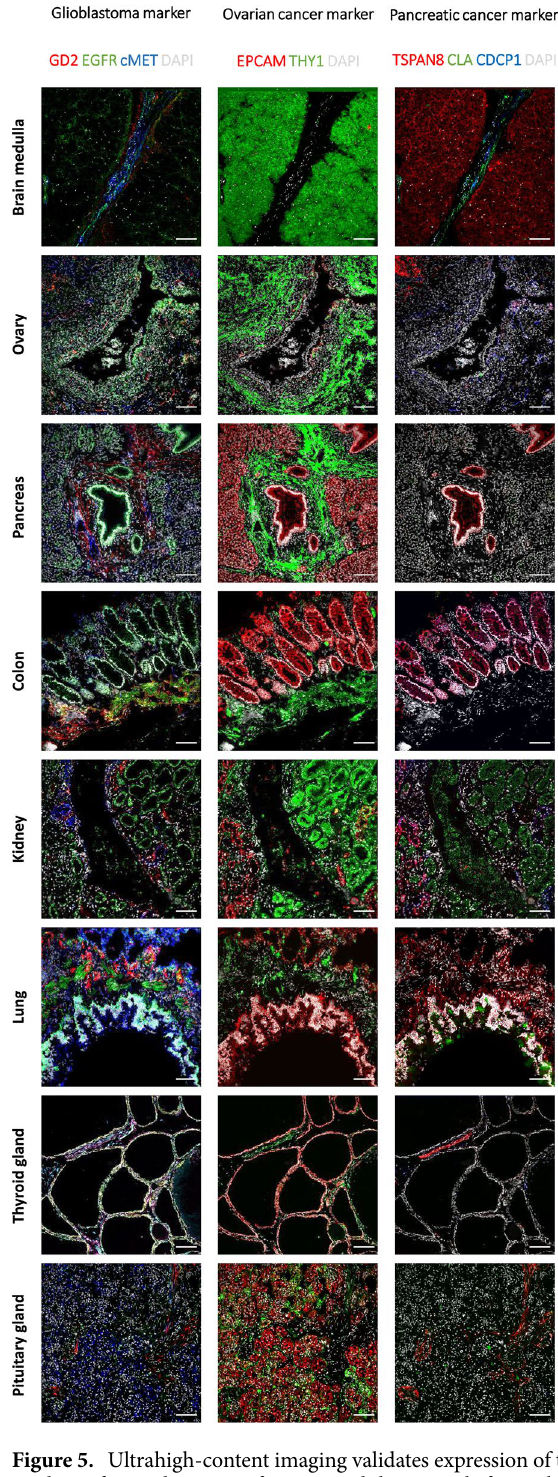
Figure 5. Ultrahigh-content imaging validates expression of target candidates on healthy human tissues to predict safety and toxicity of target candidates. Fresh-frozen human tissues were sliced and fixed with acetone. The subsequent screening was performed on the MACSima Imaging Platform by employing a sequential staining of antibodies. Healthy human tissues, i.e. medulla oblongata, ovary, pancreas, colon, kidney, lung, thyroid gland, and pituitary gland, were analyzed for the expression of glioblastoma target candidates (left panel), GD2 is shown in red, EGFR in green, cMET in blue, and DAPI in white; ovarian cancer target candidates (middle panel), EPCAM is shown in red, THY1 in green, and DAPI in white; pancreatic cancer target candidates (right panel), TSPAN8 is shown in red, CLA in green, CDCP1 in blue, and DAPI in white. Scale bar represents 100